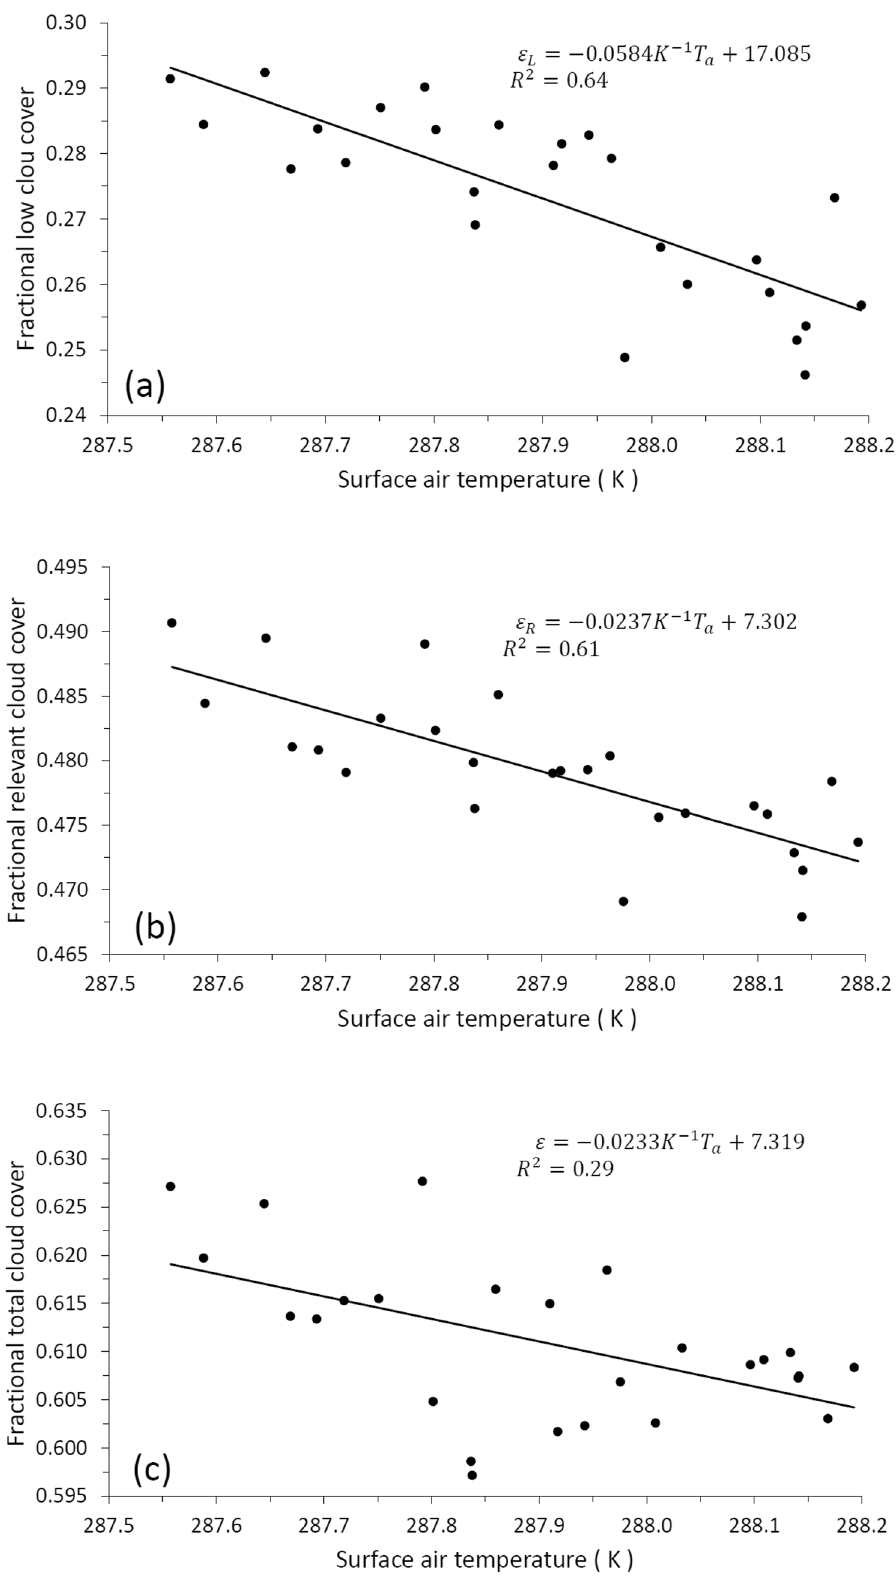
Figure 5. Correlation between cloud cover (from ISCCP) and absolute surface air temperature, obtained by adding to the temperature anomaly in Fig. 4, the standard temperature T a 0 = 288 K . The straight line shows the 2 ) long-term trend, whose equation and correlation ( R are shown in the upper right. Part ( a ) corresponds to low cloud cover, ( b ) to relevant cloud cover and ( c ) to total cloud